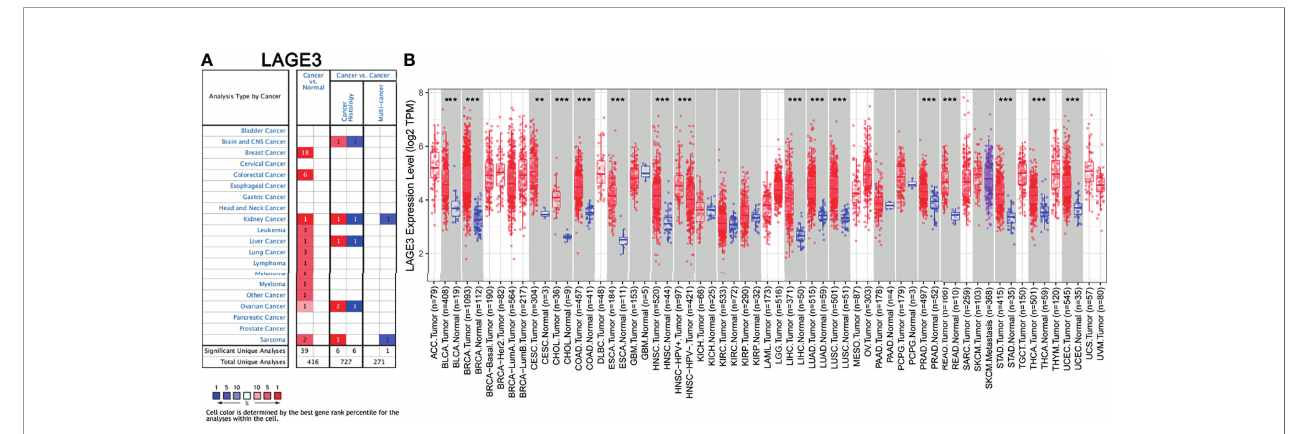
FIGURE 1 | Assessment of LAGE3 expression in different cancer and normal tissues. (A) Expression of LAGE3 in different types of human cancers in the Oncomine database. (B) Expression of LAGE3 in different types of human cancers in the TIMER database. ** P < 0.01, *** P <